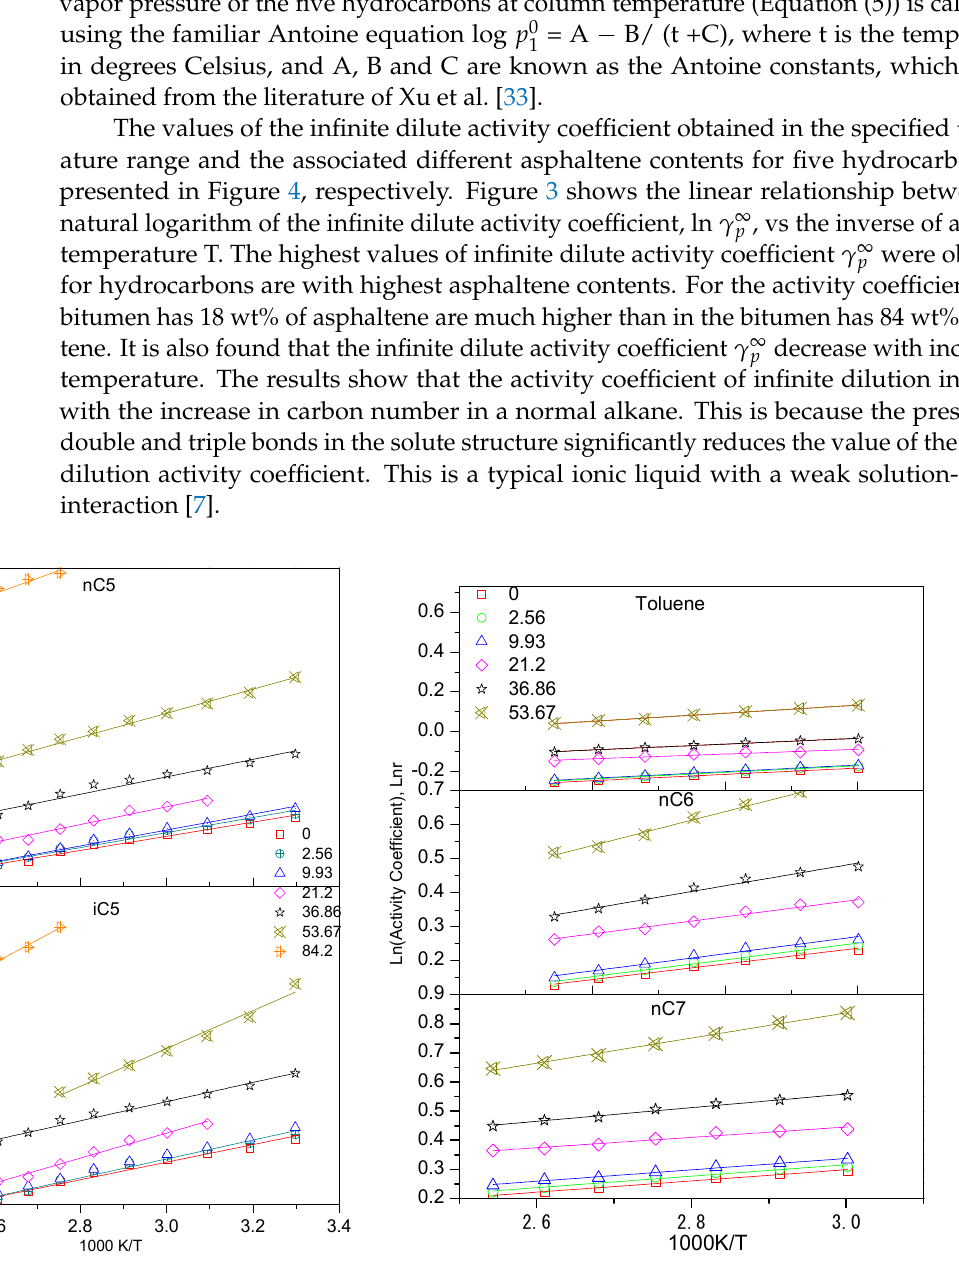
Figure 4. Linear plots for activity coefficients, ln r, vs. the inverse of absolute temperature T: nC5, iC5 nC6, nC7, and Toluene under the different asphalting contents (0, 2.56, 9.93, 21.2, 36.86, 53.67, and 84.2 wt% asphaltene).